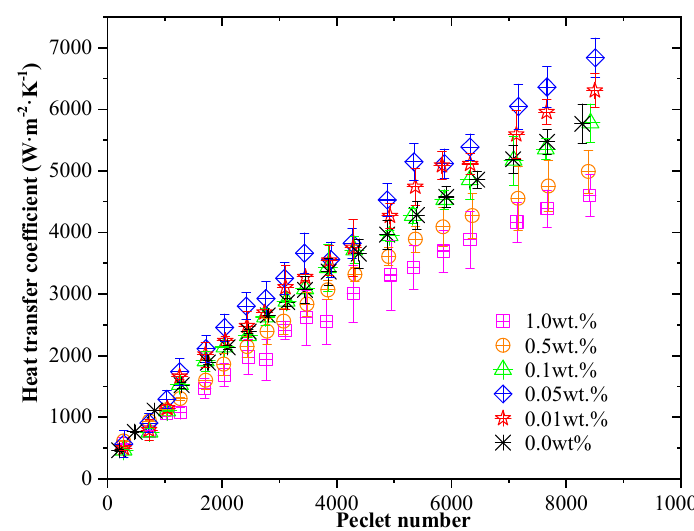
Figure 7. Convective heat transfer coefficient versus the Peclet number.